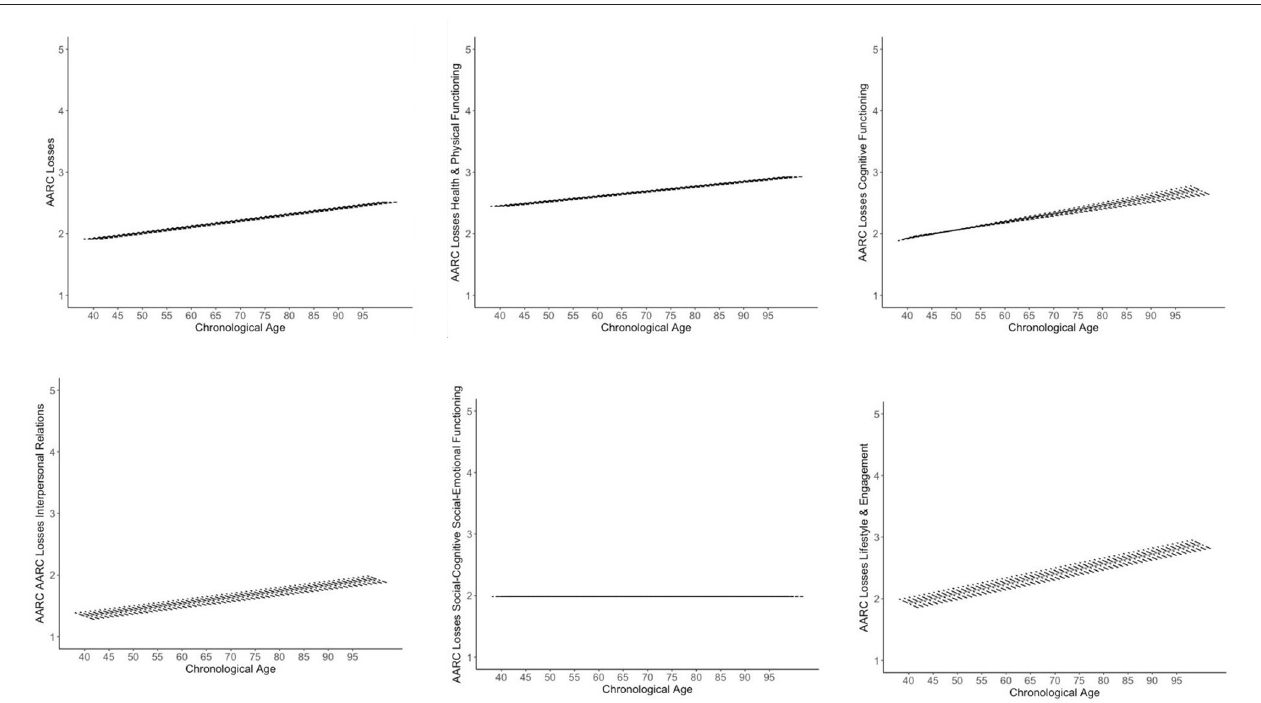
FIGURE 2 | Trajectories of AARC losses. Figures adapted from Gerstorf et al. (84). The figure shows model-implied 5 year within-person changes in AARC losses by baseline age as short, thick lines. The single linear age trend in AARC losses is shown as long, thin line. Models are adjusted for gender, education, and self-rated health. The graphs illustrate a general trend of mean-level stability in AARC losses across the different domains, with the exception of losses in interpersonal relations and in lifestyle and engagement, which decreased over time. At the same time, perceived losses in general and across most domains at baseline were greater among individuals who were older. Only losses in socio-cognitive/social-emotional functioning were not related with age. The association of losses in interpersonal relations with age was non-linear (see Supplemental Figure 1